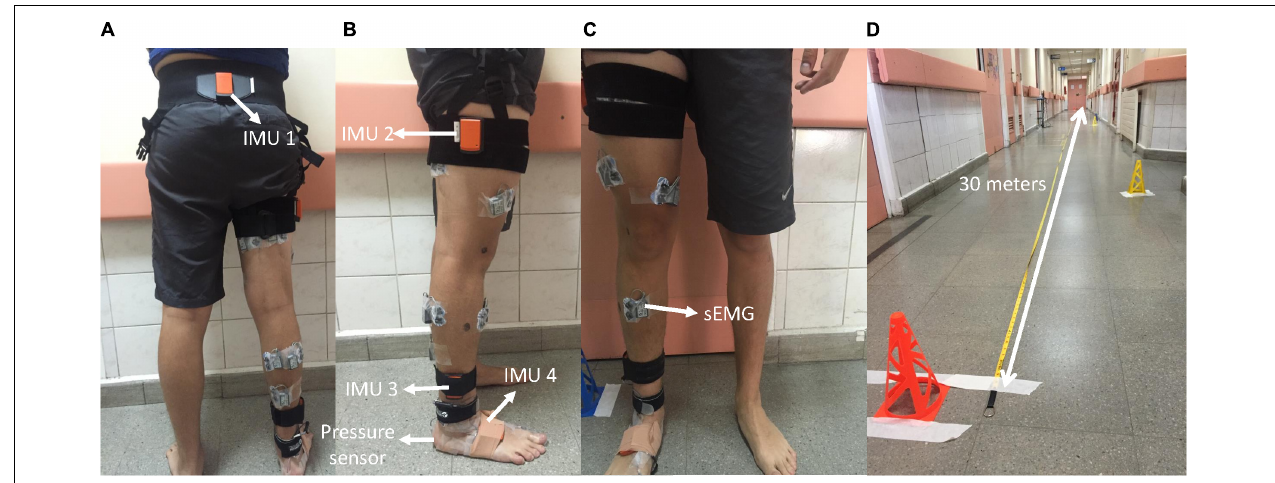
FIGURE 1 | Sensors locations and 30 m used corridor. (A) Back view. (B) Lateral view. (C) Frontal view. (D) Walking assessment corridor. Surface electromyography (sEMG), inertial sensor positioned in pelvis (IMU 1), inertial sensor positioned in lateral face of thigh (IMU 2), inertial sensor positioned lateral face of the shank (IMU 3), and inertial sensor positioned in midfoot (IMU